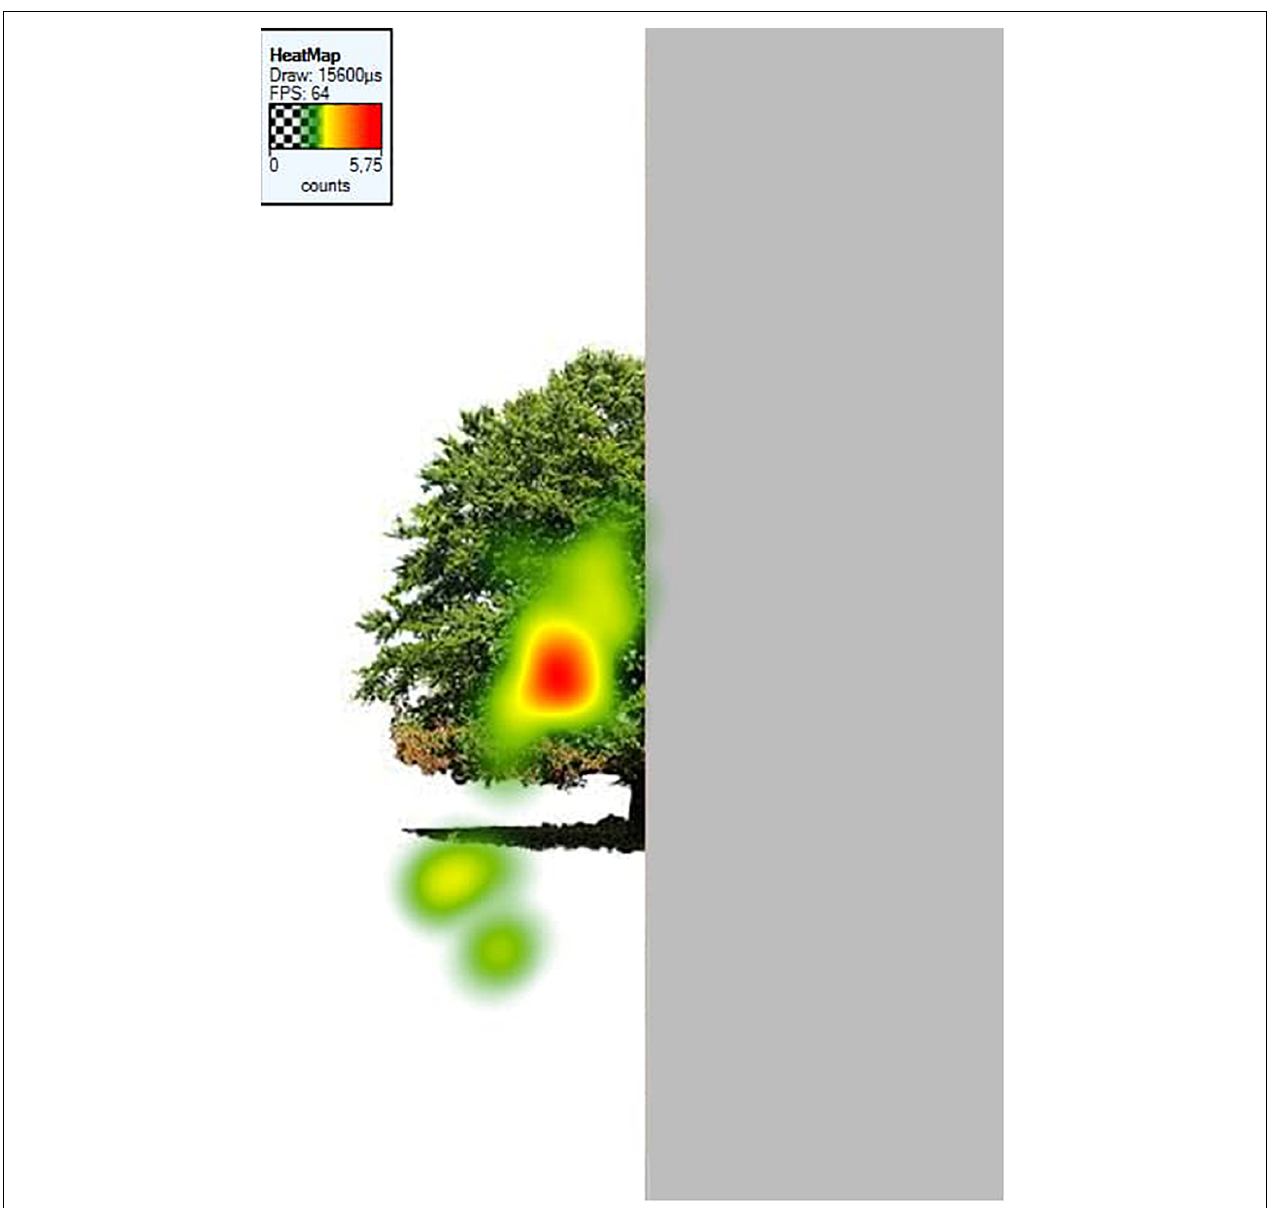
FIGURE 13 | Fixation heatmap of a left upright tree